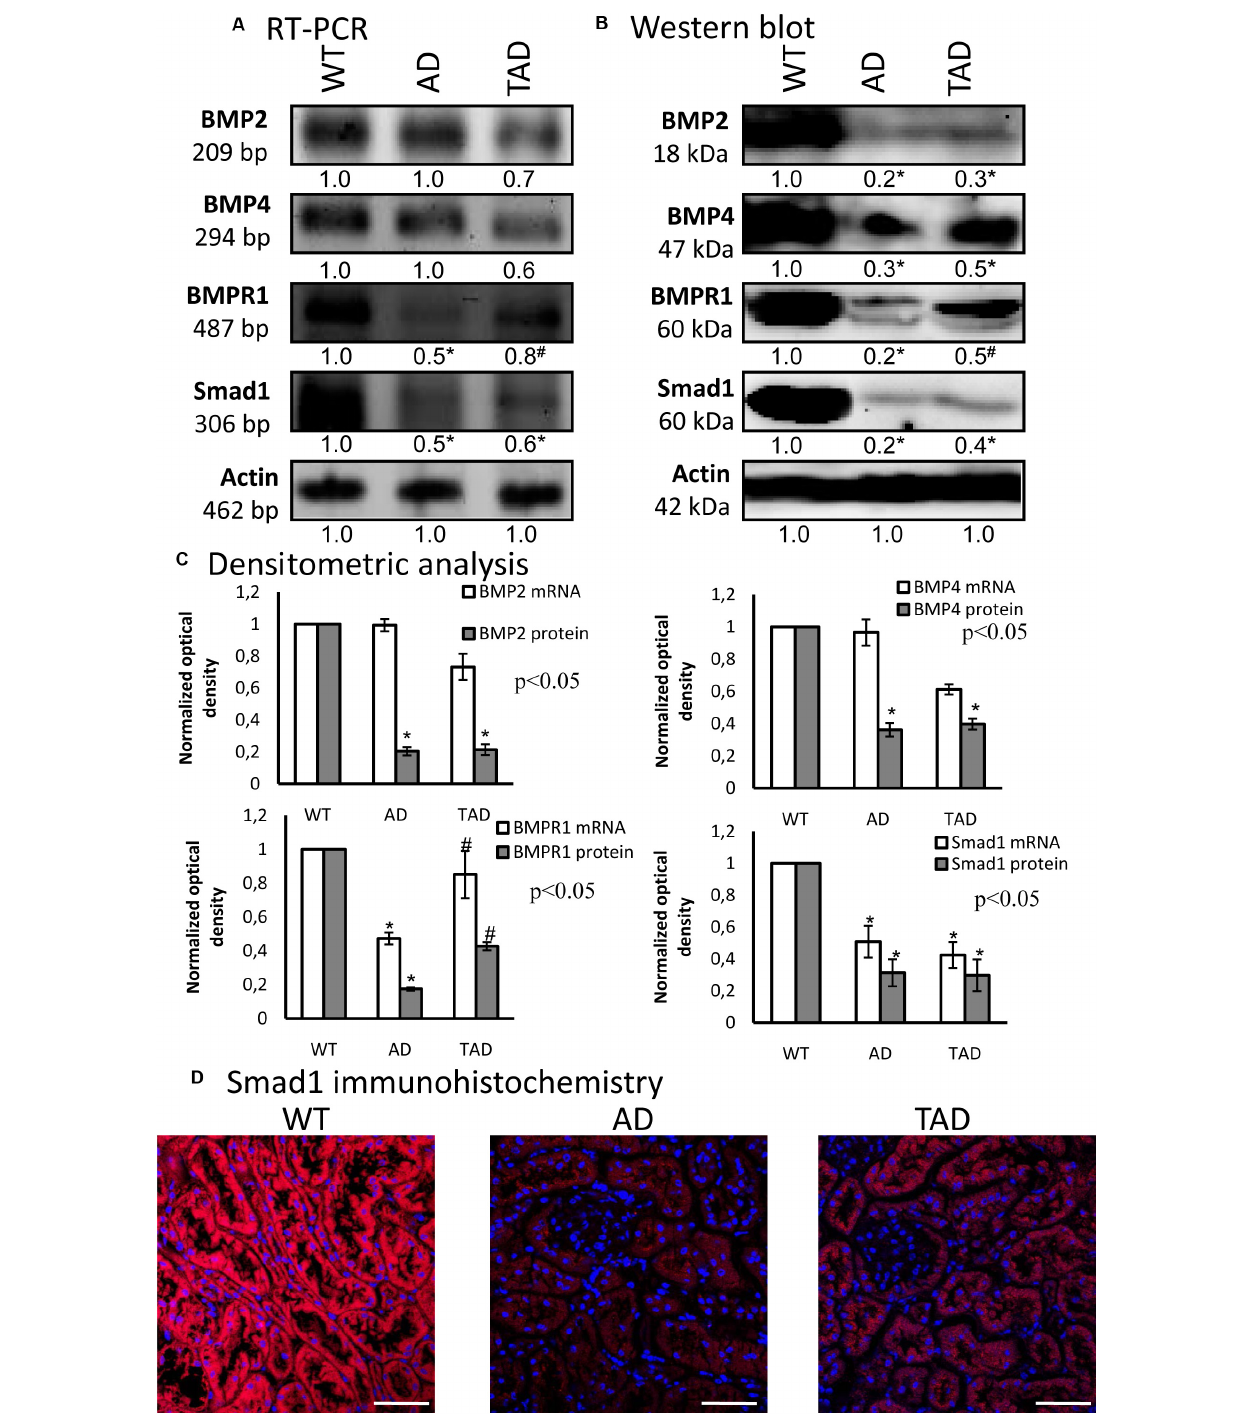
FIGURE 4 | mRNA (A) and protein (B) expressions of bone morphogenetic protein (BMP) signaling in the kidneys. For reverse transcription PCR (RT-PCR) and for Western blot, actin was used as the control. The optical density of the signals was measured and the results were normalized to the optical density of the controls. For panels (A) and (B) , the numbers below the signals represent the integrated densities of the signals determined by ImageJ software. Asterisks indicate significant ( ∗ p < 0.05) alterations of expressions as compared to the wild type (WT) and ( # p < 0.05) compared to Alzheimer’s disease (AD). Representative data of five independent experiments. (C) Statistical analysis of the RT-PCR and Western blot data. All data presented are the averages of at least five different experiments. Statistical analysis was performed with Student’s t -test. All data were normalized on actin and are expressed as the mean ± SEM. (D) Immunohistochemistry of Smad1 in the cortex of the kidneys. Magnification was made with × 60 objective. Scale bar , 20 µ m.